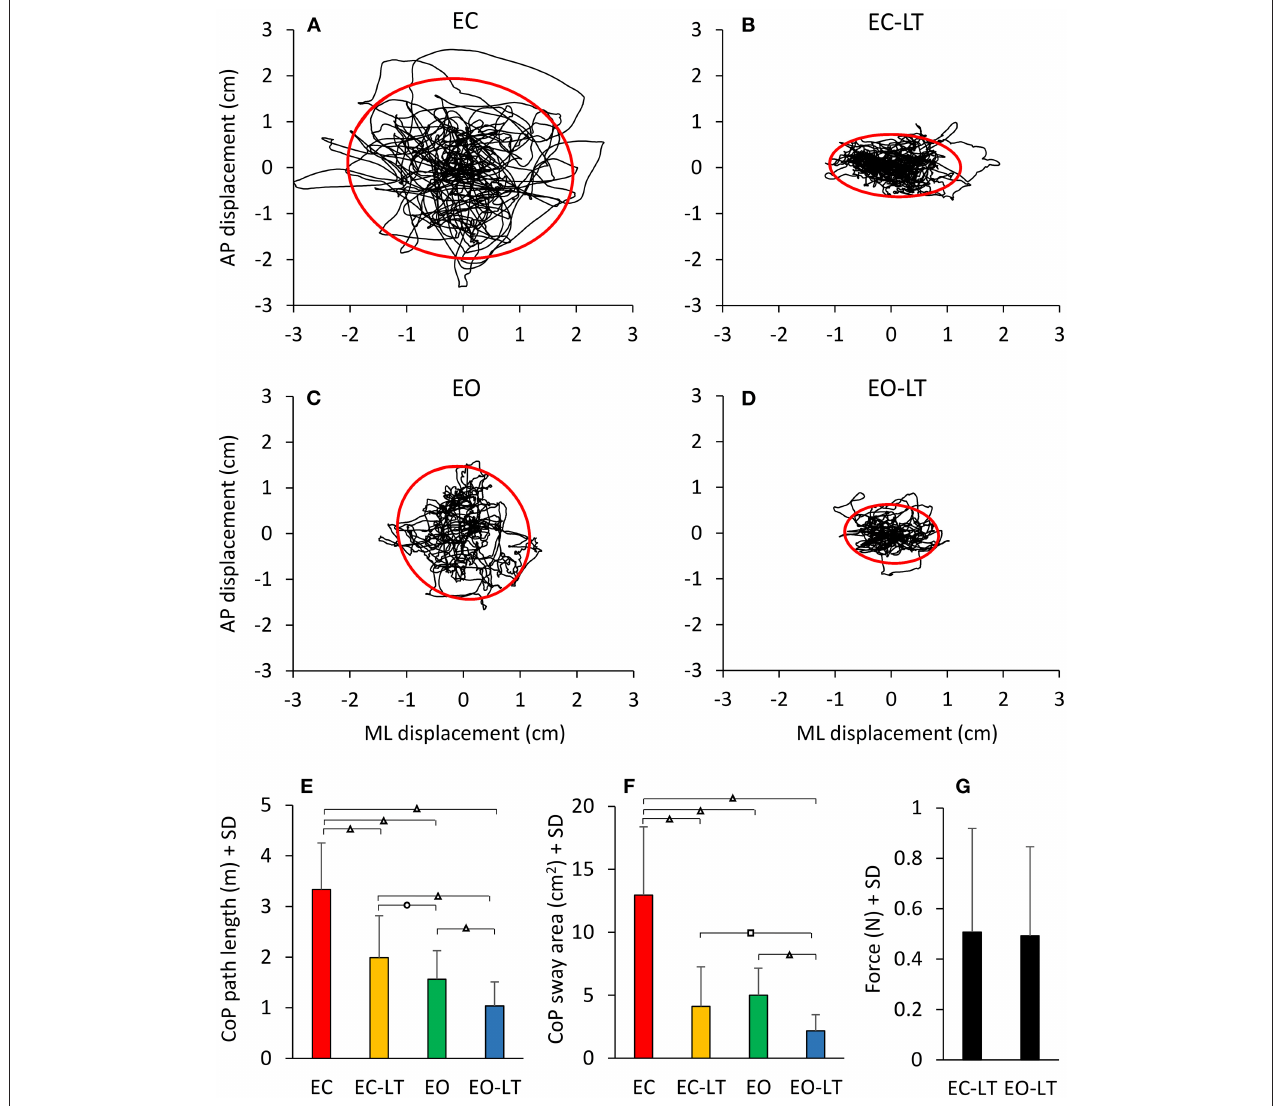
FIGURE 10 | Geometric sway measures. The four top panels show representative diagrams of the CoP sway trajectory (black line) together with the 95% ellipse profile (red) in one subject in the four sensory conditions tested on foam (A–D) . The diagrams broadly match the mean values of path length (E) and sway area (F) of the entire cohort of subjects. There is a discordance in the two metrics (length and area), whereby the path length diminishes with EC-LT and EO-LT, but the sway area decreases proportionally more. (G) The fingertip forces applied to the force pad during the touch conditions (both EC-LT and EO-LT) were similar. Distinct symbols indicate significant differences ( 2 p < 0.05; ◦ p < 0.01; 1 p < 0.001).